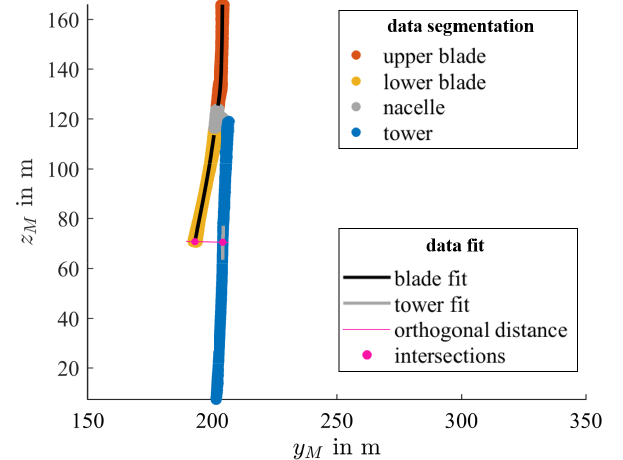
Figure 2. Results of data segmentation: the assignment of the valid measuring data is color coded according to the legend. Furthermore, the fitting results of the tower and the rotor blade data points are presented, together with the intersections used to calculate the or- thogonal distance between the lower-blade tip and the